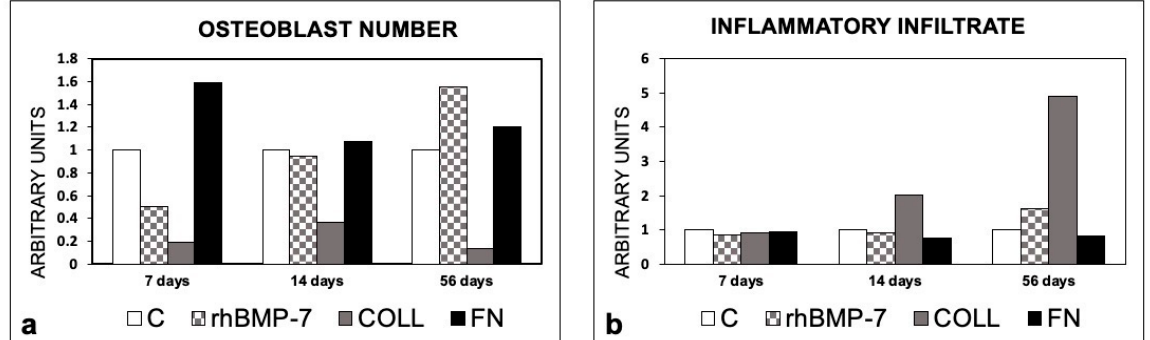
Figure 7. Osteogenesis and inflammatory process in peri-implant bone tissues from sites treated with rhBMP-7, Type 1 Collagen, or Fibronectin. ( a ) Osteogenesis was evaluated as the number of osteoblasts counted per high-power field (mean of 10 fields) and expressed as ratio of control sites taken as 1. ( b ) The inflammation process was evaluated as the number of neutrophilic granulocytes (7 days) and mononucleated (lymphocytes, plasma cells, macrophages, 14 and 56 days) inflammatory cells per high-power field (mean of 10 fields) and expressed as a ratio on control sites taken as 1. C, control sites; rhBMP-7, sites treated with rhBMP-7; COLL, sites treated with Type 1 Collagen; FN, sites treated with Fibronectin.